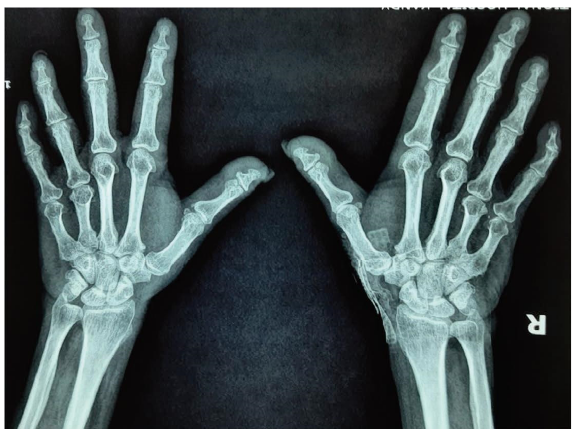
Figure 4: X-ray of bilateral hands showing brachymetacarpia.